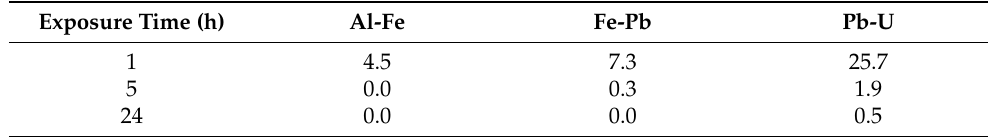
Figure 6. ρ c (per minute) vs. θ avg (degree) plot for 1 h, 5 h, and 24 h data. Table 1. Misclassification rate (R m ) for different combination of material blocks.